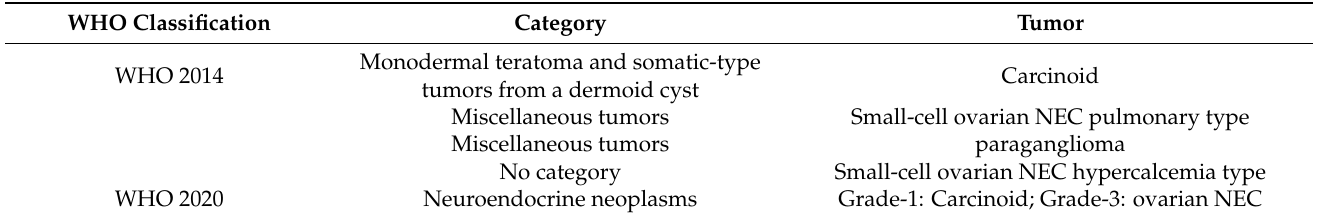
Table 6. Differences between WHO’s 2014 and 2020 classification of ovarian neuroendocrine tumors.